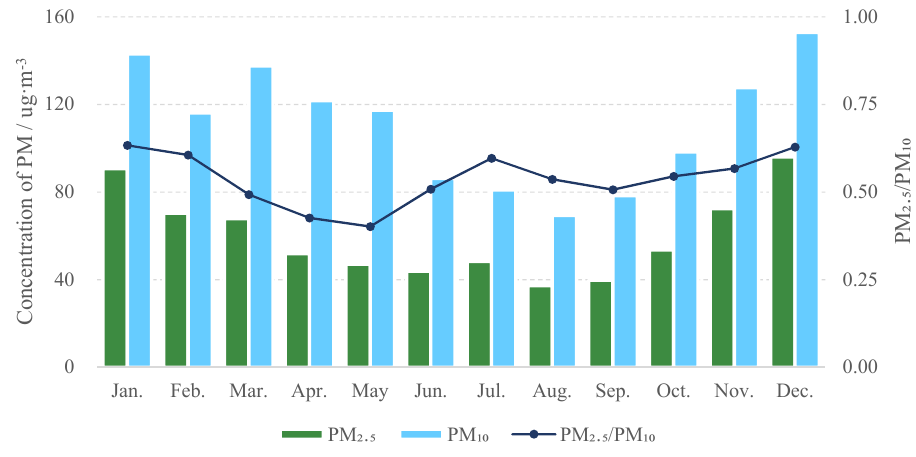
Figure 8. Temporal variation in the monthly mean value of atmospheric particulate matter concen ‐ tration.